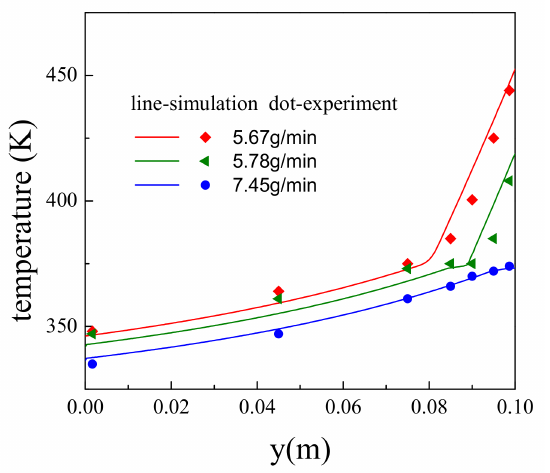
Figure 2. Comparison of numerical results and experimental